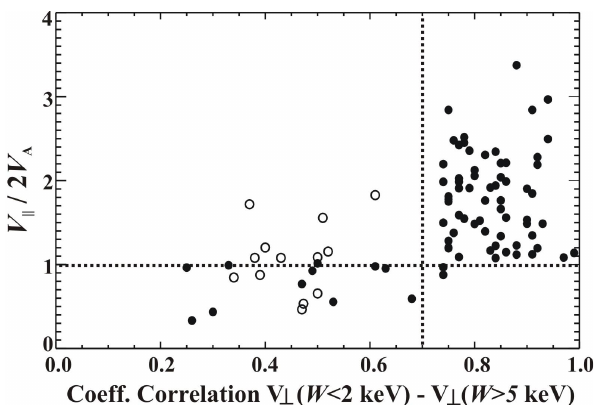
Fig. 15. Scatterplot of the parallel velocities of high-energy ions normalized to the double value of the local Alfv´en velocity, cal- culated for each PSBL crossing, versus the coefficients of correla- tion between the perpendicular velocities of high- and low-energy ions. The PSBL crossings, where the density of low-energy ions was < 0.01cm − 3 , are shown by empty